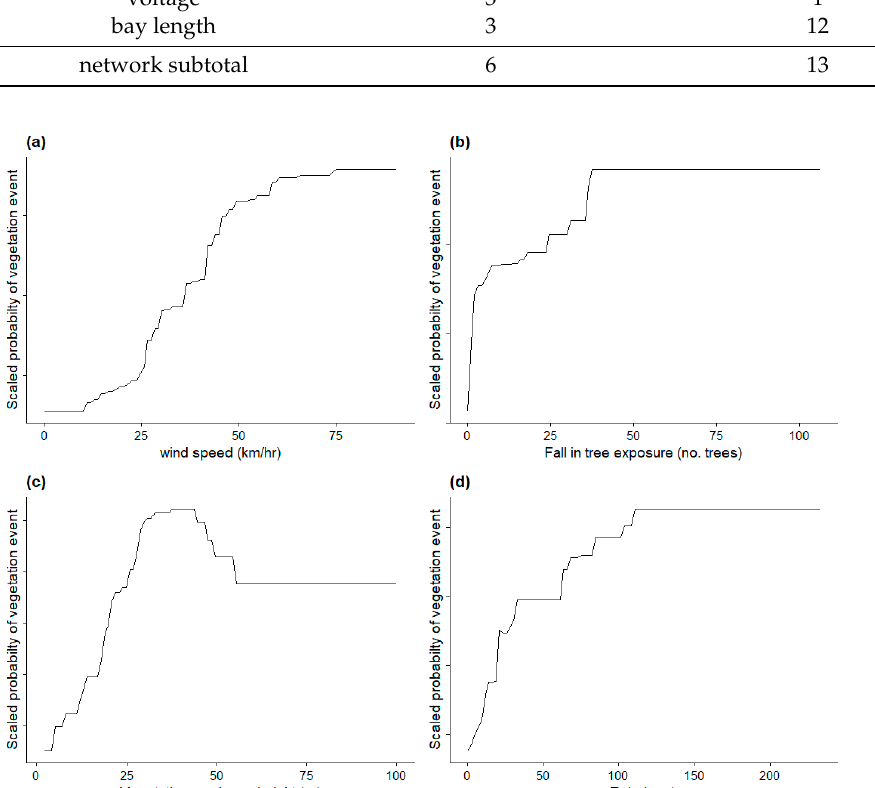
Figure 2. Marginal effect plots for ( a ) wind speed; ( b ) fall-in tree exposure; ( c ) vegetation